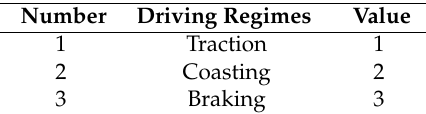
Table 2. Definition for driving